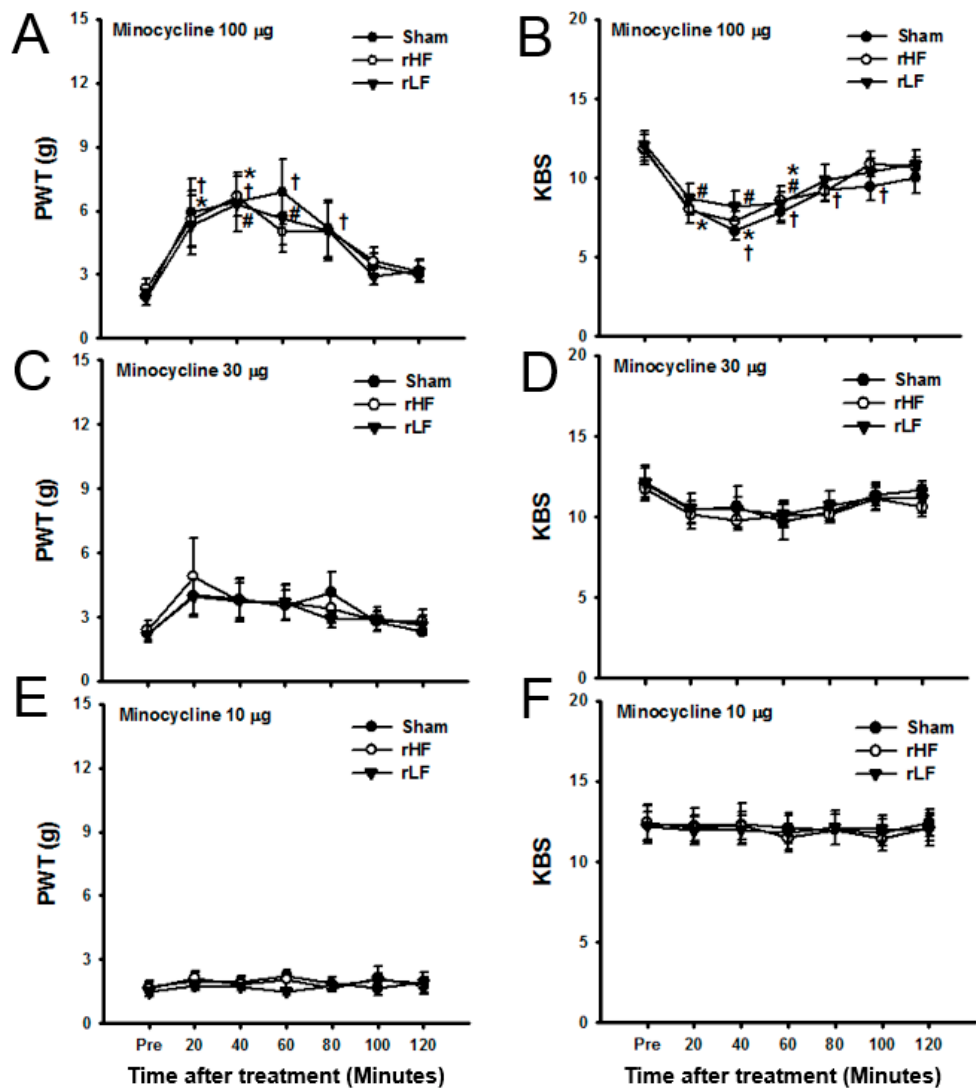
Figure 4. The effect of minocycline on osteoarthritic pain in transcutaneous electric nerve stimulation (TENS)-tolerant rats. The paw withdrawal threshold (PWT) ( A ) and knee-bend score (KBS) ( B ) of the ipsilateral side in TENS-tolerant rats significantly changed after intrathecal minocycline (100 µ g) injection. The PWT ( C ) and KBS ( D ) of the ipsilateral side in TENS-tolerant rats did not significantly change after intrathecal minocycline (30 µ g) injection. Moreover, minocycline (10 µ g) did not change the PWT ( E ) and KBS ( F ) in TENS-tolerant rats. Asterisks (*) indicate values significantly di ff erent from the value before TENS in the repeated high-frequency (HF) TENS group. Number signs (#) indicate significant changes in the values compared with the value before TENS in the repeated low-frequency (LF) TENS group. Dagger signs ( † ) indicate significant changes in the values compared with the value before TENS in the sham TENS group.